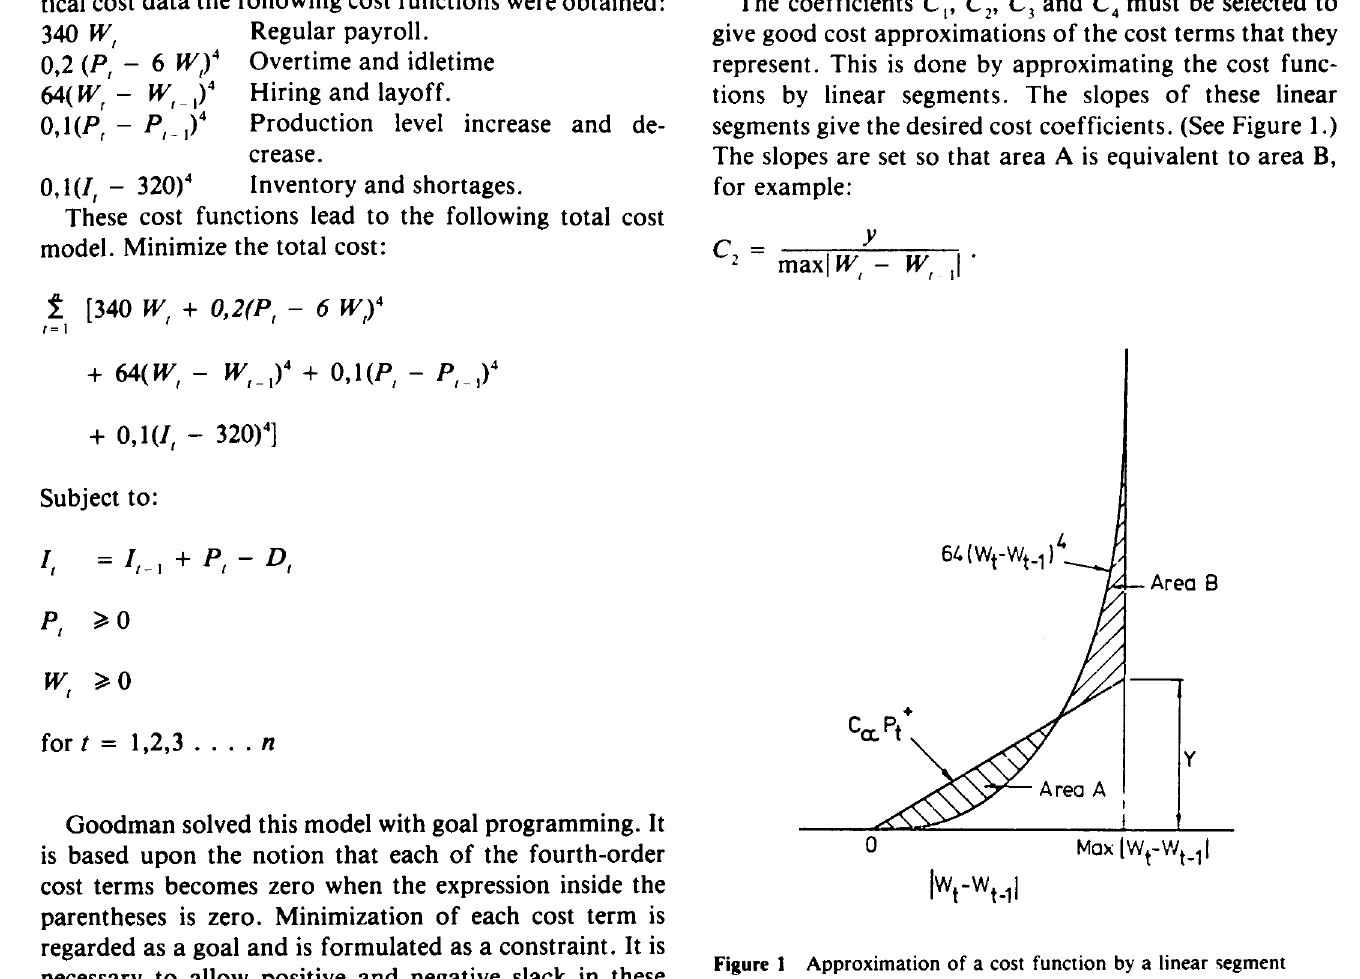
Figure 1 Approximation of a cost function by a linear segment